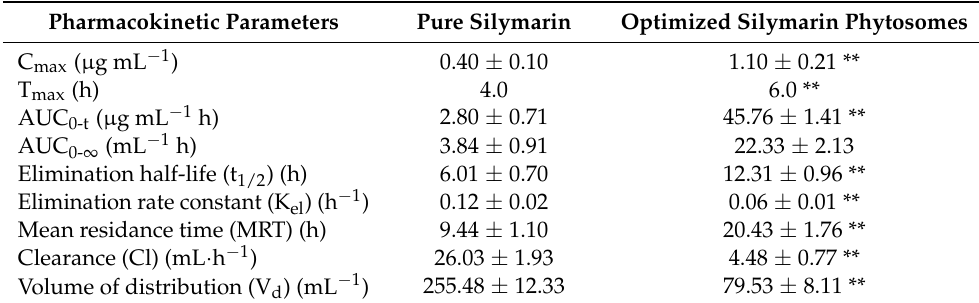
Table 5. Pharmacokinetic parameters of pure silymarin and (100 mg/kg, p.o.) and optimized silymarin phytosomes (~100 mg/kg silymarin, p.o). Pharmacokinetic Parameters Pure Silymarin Optimized Silymarin Phytosomes C max ( µ g mL − 1 ) 0.40 ± 0.10 1.10 ± 0.21 ** 4.0